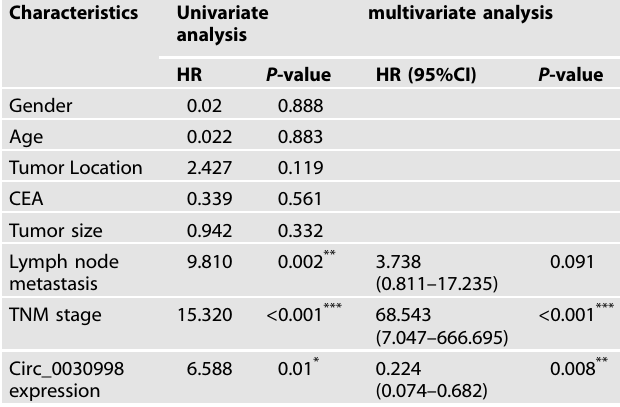
Table 2. Univariate and multivariate analysis of prognostic factors for overall survival in CRC